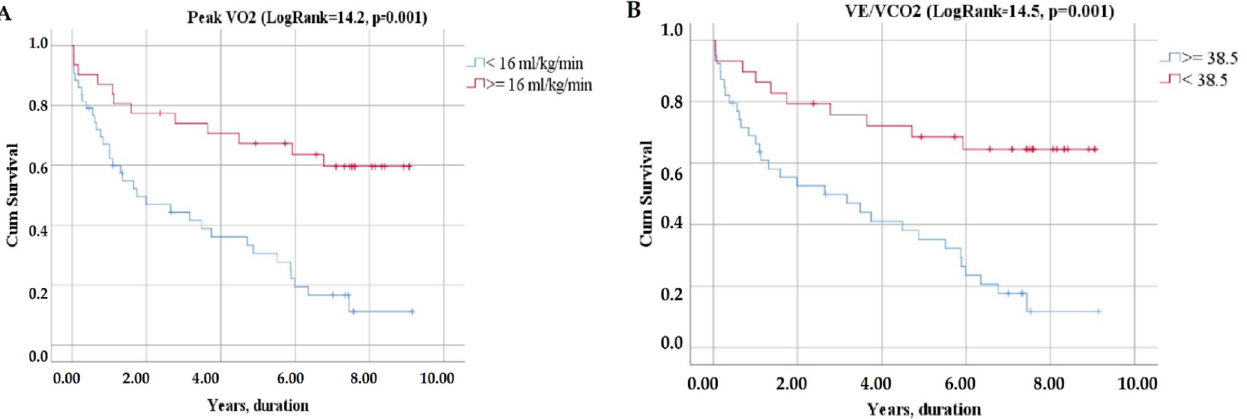
Figure 5. Kaplan–Meier curves of event-free survival according to CPET parameters: V0 2 peak ( A ), VE/VCO 2 ( B ).